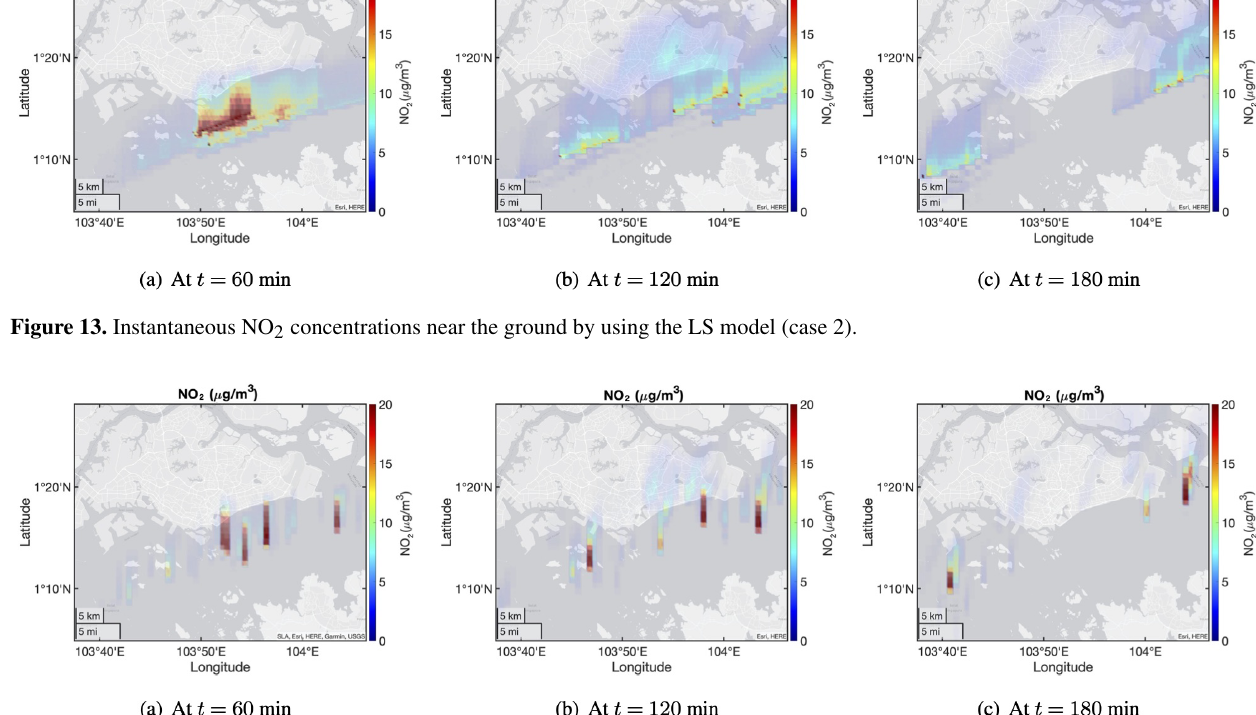
The hourly averaged NO 2 concentrations at the data point for three emission source models are presented in Fig.